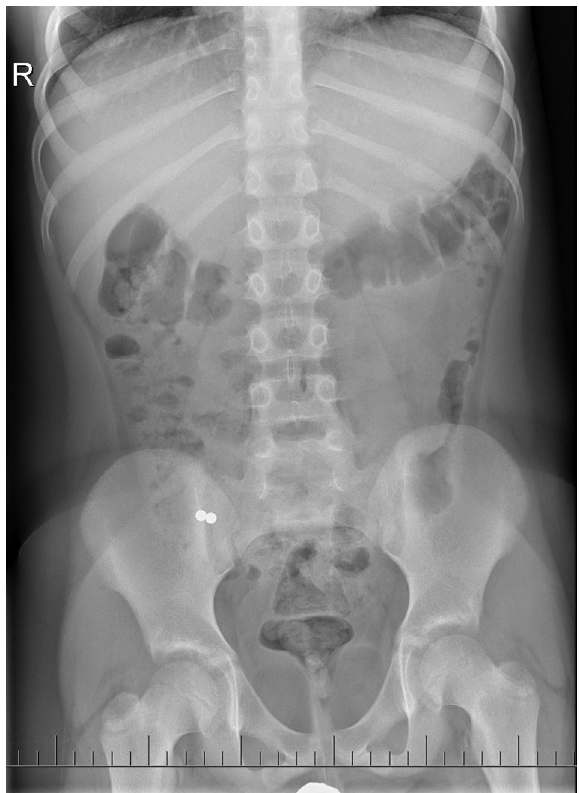
Fig. 1 The location of MFBs on an abdominal X-ray native abdominal image. MFBs, magnetic foreign bodies.